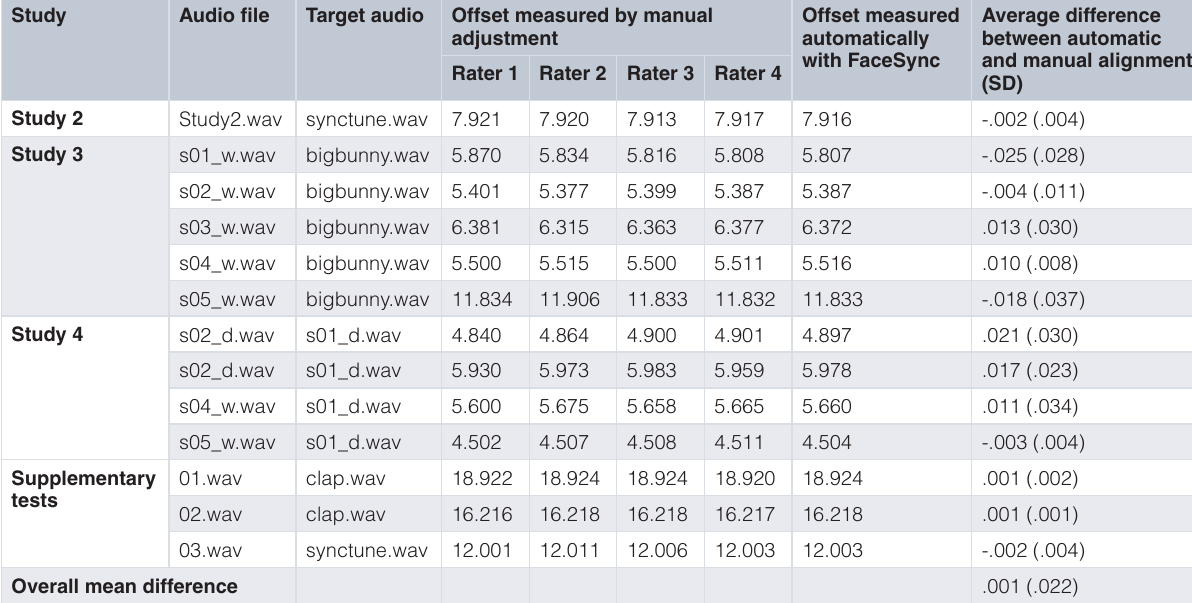
Table 2. Audio alignment results for study 2 – 4.